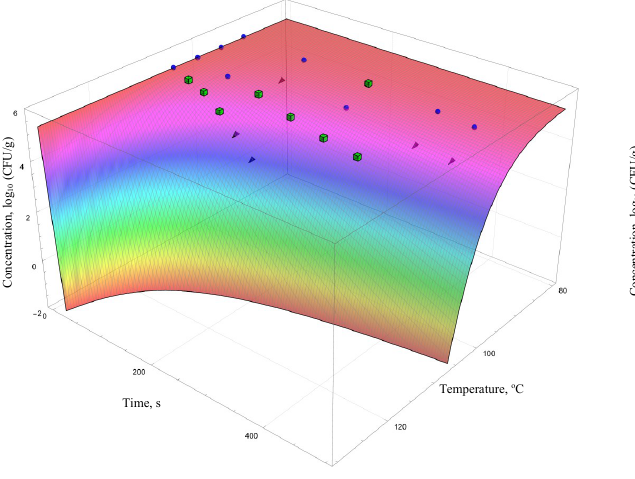
(b) Figure 5 Secondary linear models of microbial death of A. acidoterrestris during heat treatment. (a) Bigelow model, (b) Whiting-Buchanan